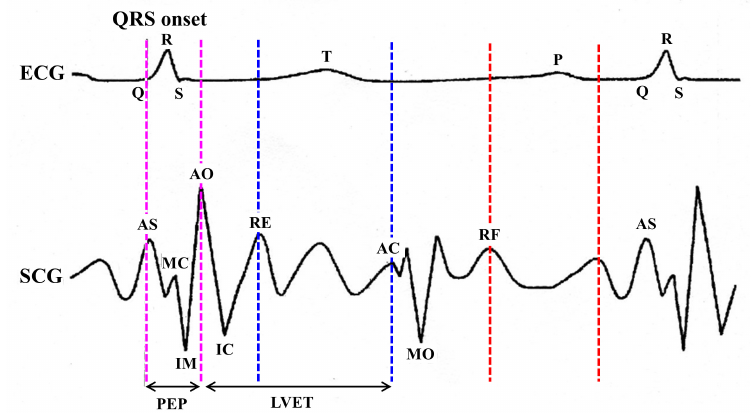
Figure 2. Cardiac electrical and mechanical